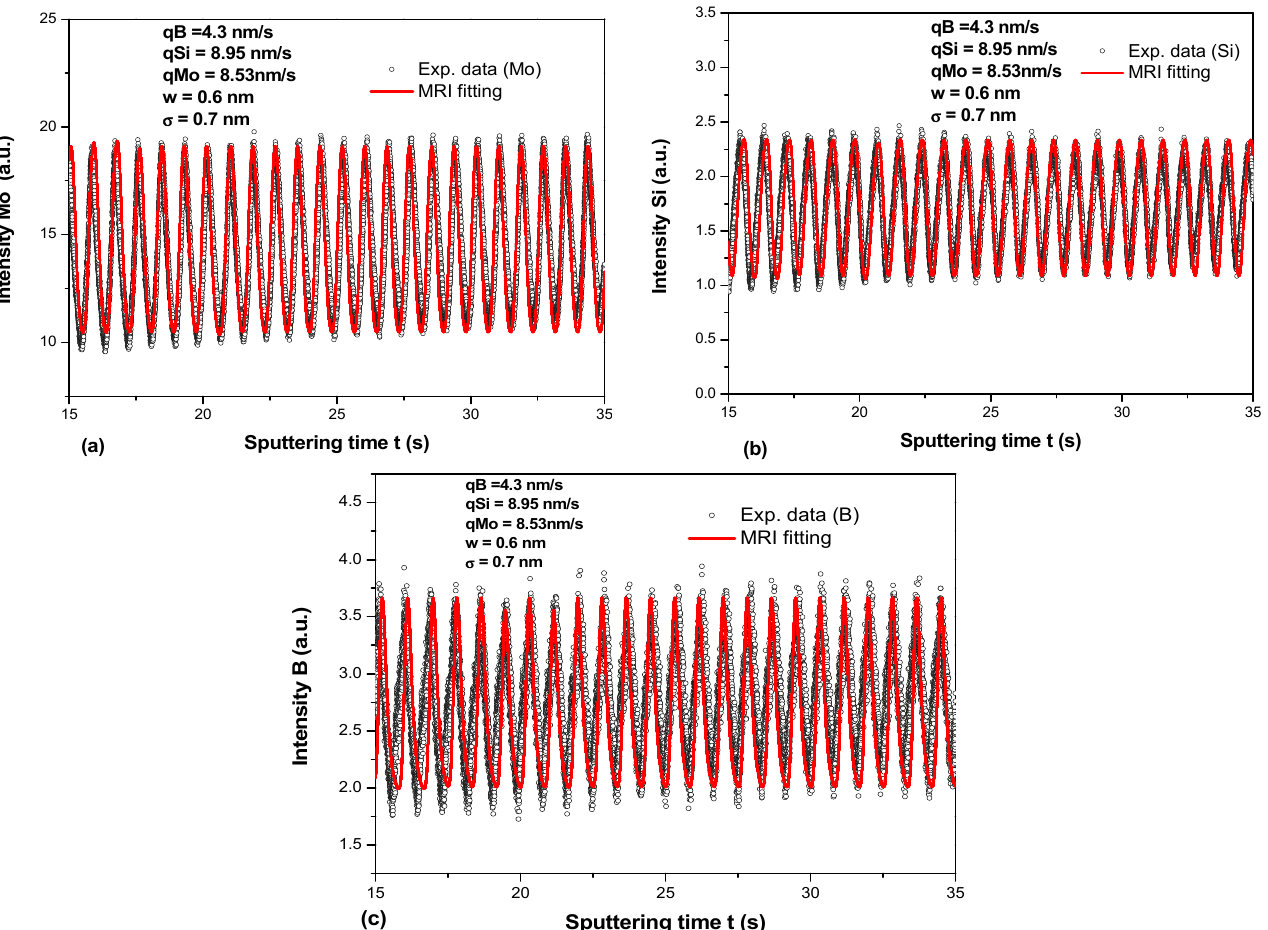
Figure 7. The measured GDOES depth profiling data (open circles) and the best fitted results (solid lines) for ( a ) Mo; ( b ) Si; and ( c ) B layers with the MRI parameters shown in the inset.